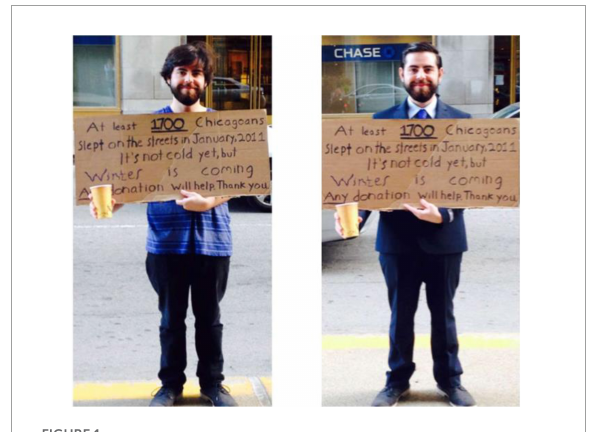
FIGURE1 The confederate (the study first author) wearing low (left) and high (right) status symbols at W. Jackson Blvd between S. Michigan and S. Wabash streets. Images are intended for demonstration purposes only (i.e., they do not represent exactly what participants saw). Bennett Callaghan served as stimuli for the study